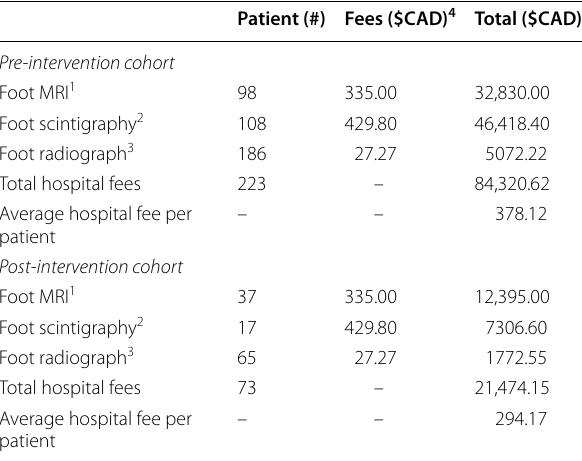
Table 2 Comparative data for the pre‑ and post‑intervention cohorts